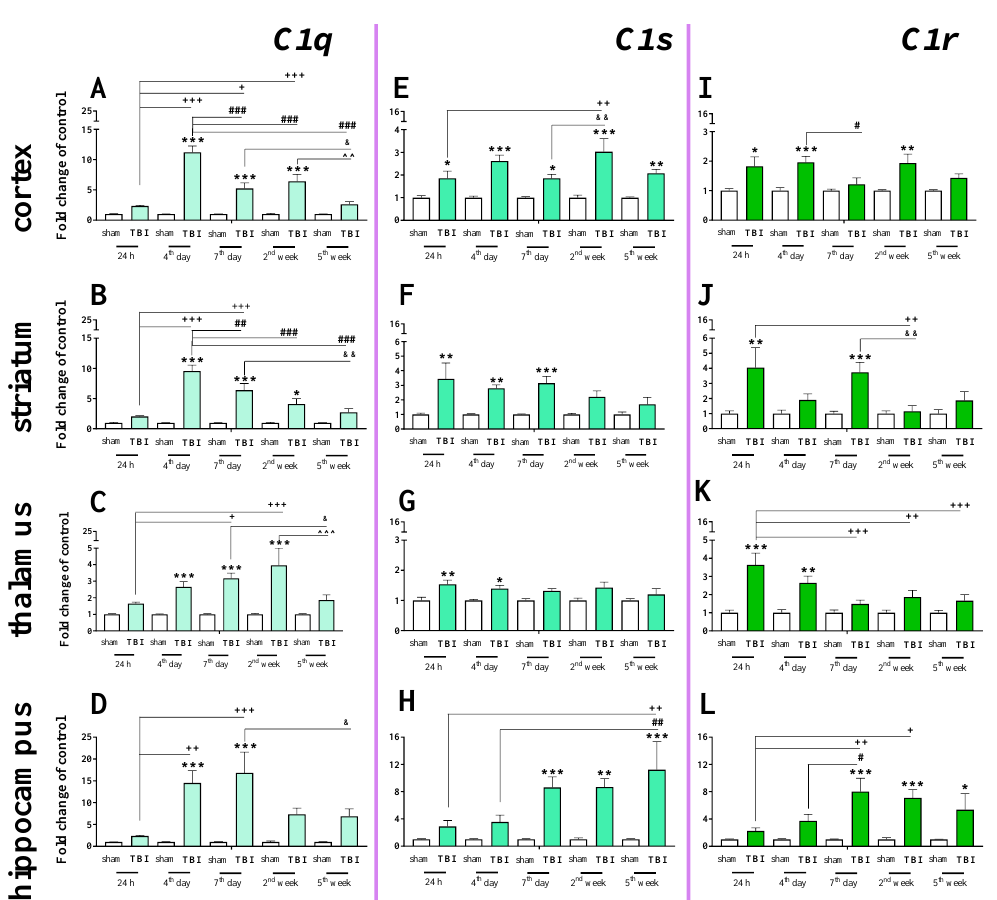
Figure 4. ( A – L ). The mRNA expression changes of C1q, C1s, and C1r in the cortex, striatum, thalamus, and hippocampus of TBI compared to sham-injured animals at different time points (24 h–5 weeks). The data are given as fold changes relative to the control as mean ± SEM (sham groups, n = 3–8; TBI groups, n = 4–8). * p < 0.05; ** p < 0.01; *** p < 0.001 show differences considered statistically significant between the sham and TBI groups, + p < 0.05; ++ p < 0.01; +++ p < 0.001 show differences considered statistically significant comparing to the 24 h TBI group; # p < 0.05; ## p < 0.01; ### p < 0.001 show differences considered statistically significant comparing to the 4th day TBI group; & p < 0.05; && p < 0.01 show differences considered statistically significant when comparing to the 7th day TBI group; ^^ p < 0.01; ^^^ p < 0.001 show differences considered statistically significant comparing to the 2 weeks TBI group as estimated by two-way ANOVA followed by Bonferroni’s post hoc test.